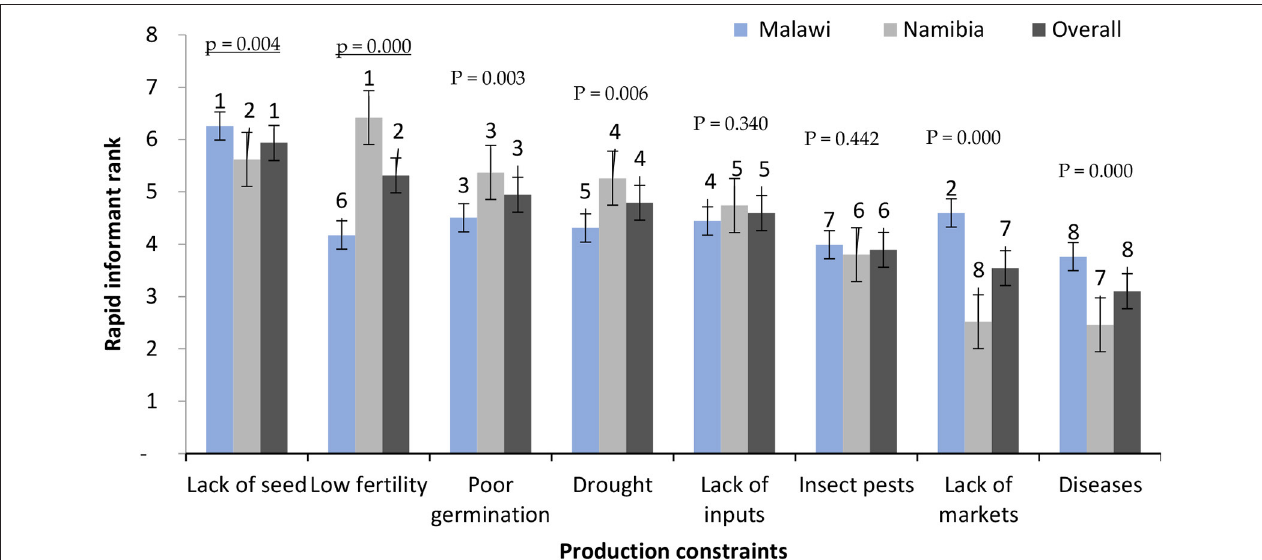
FIGURE 2 | Ranking of the production constraints by 197 farming households in Malawi and Namibia based on a hedonic scale of 1 representing the most critical constraint and 8 representing the least critical constraint. The values on top of each bar indicates the rank of each constraint relative to the other constraints per category, while the p-values are based on the Kruskal Wallis